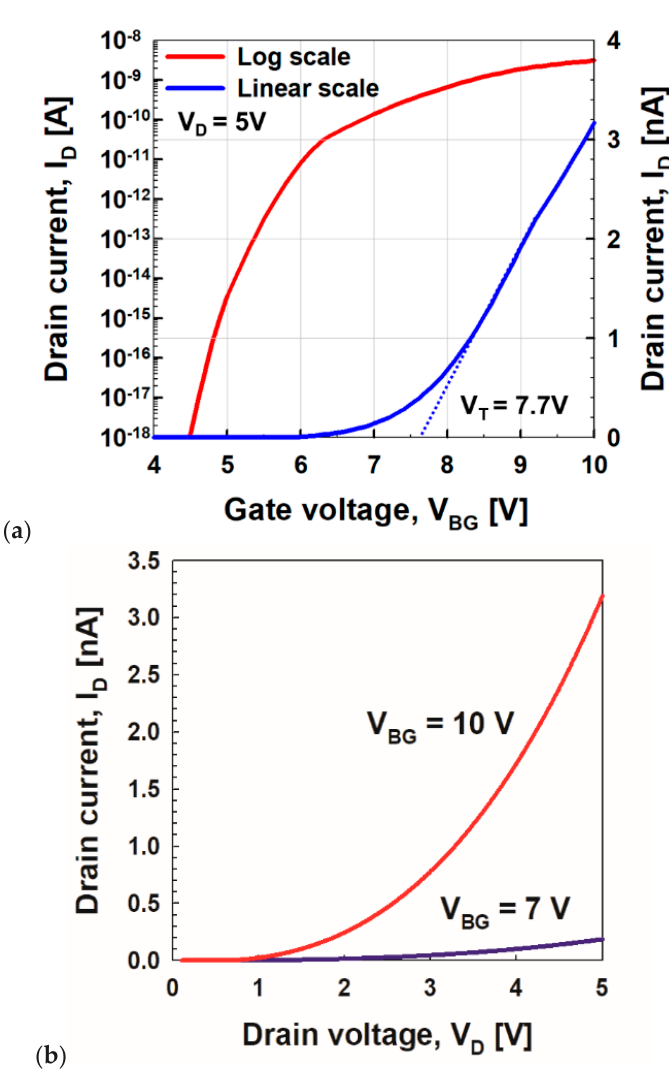
Figure 2. Simulated ( a ) drain current ( I D ) vs. back-gate voltage ( V BG ) and ( b ) I D vs. drain voltage ( V D ) without ferroelectric capacitors.